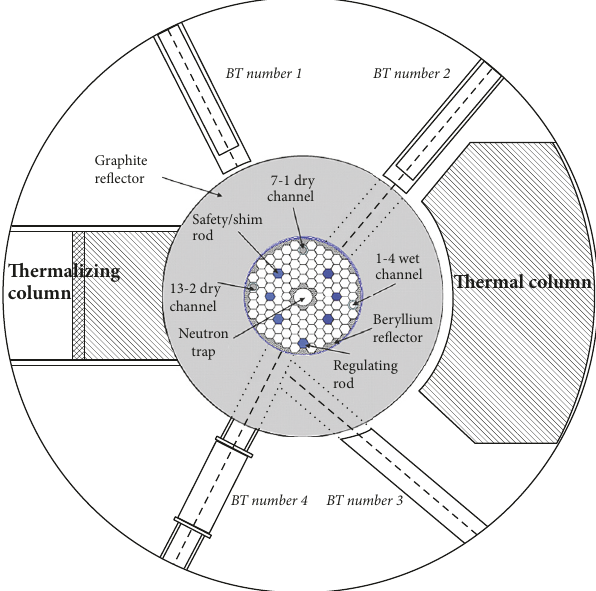
Figure 1: Horizontal view of the DNRR.